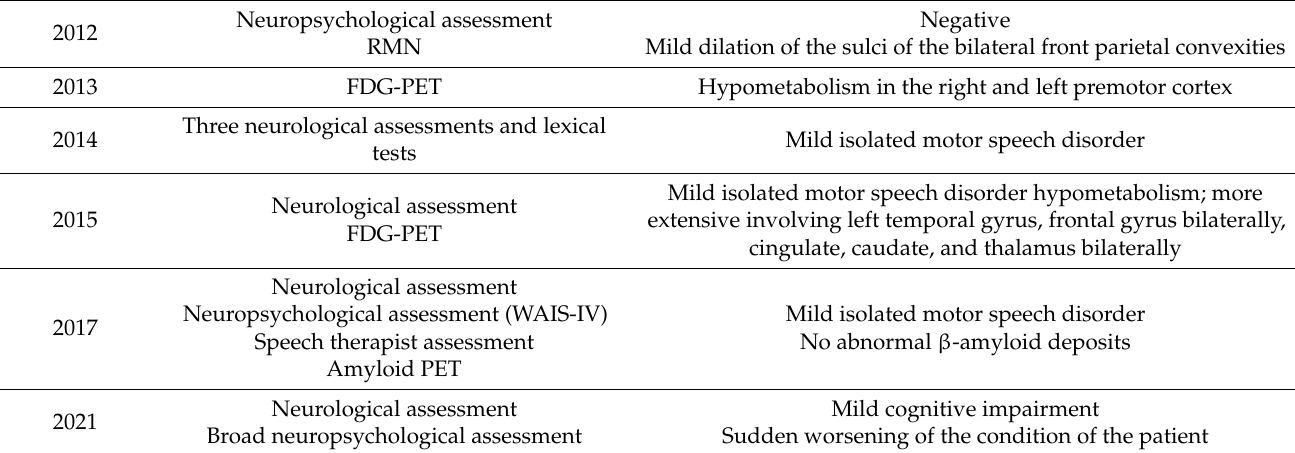
Table 2. Timeline of neurological, neuropsychological, and neuroradiological